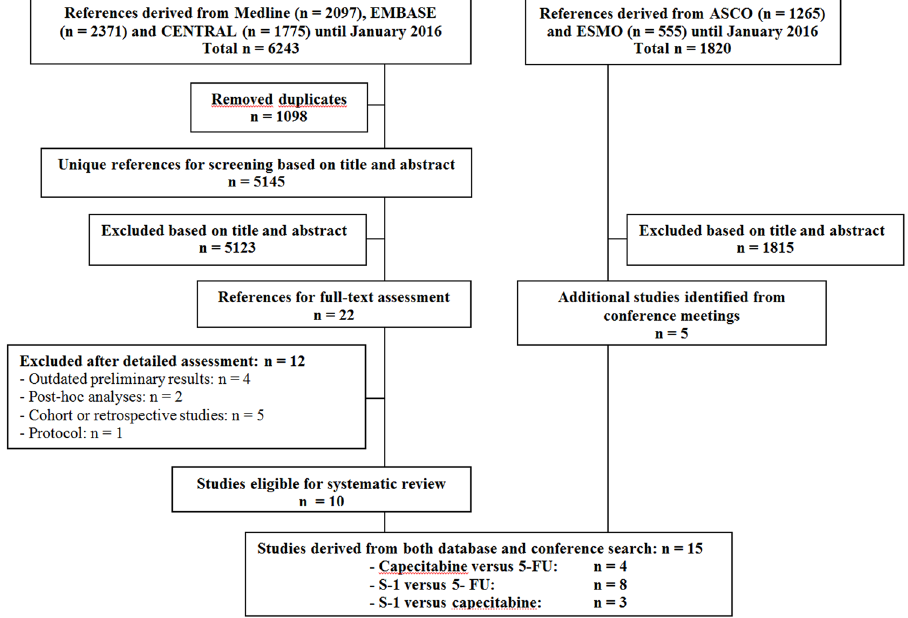
Figure 1. Flowchart of included studies. Flowchart of references derived from database search (left) and from conference search